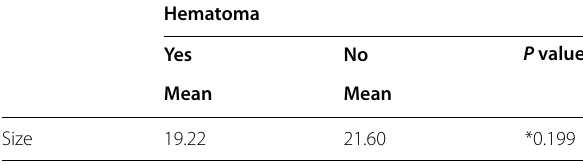
Its occurrence was statistically significant in patients who experienced pain during the procedure Hematoma formation was not statistically significantly related to size of lesion ( P value < 0.005 considered significant)